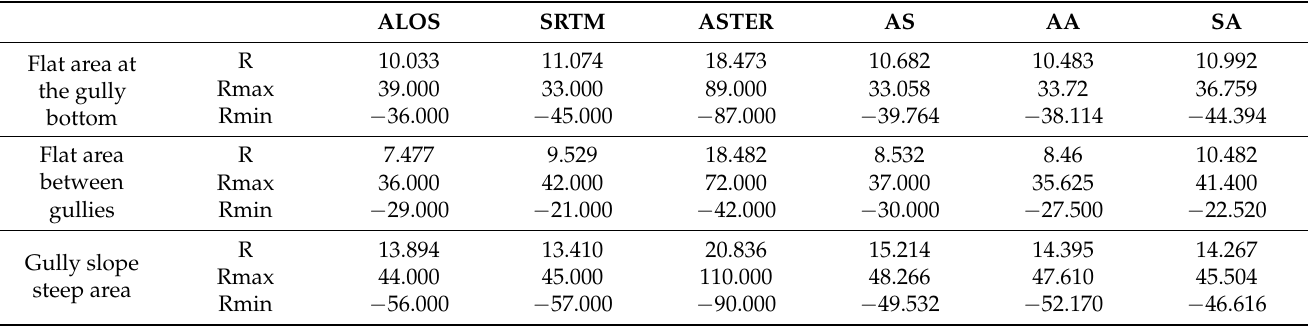
Table 9. The error statistical value of partition-weighted fusion in Chunhua (unit: m). ALOS SRTM ASTER AS